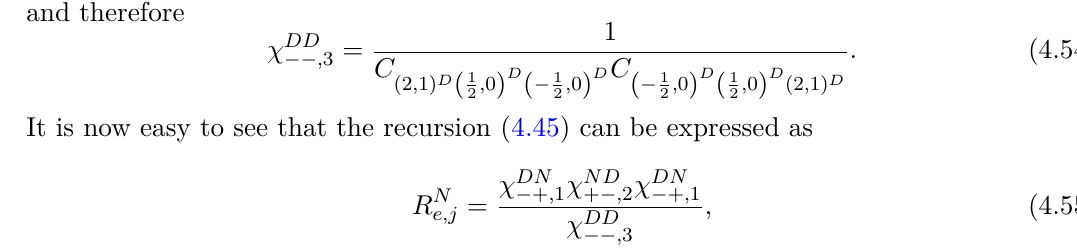
Φ D Φ D Φ D i 2 , 1 2 , 1 1 1 , 0 , 0 2 2